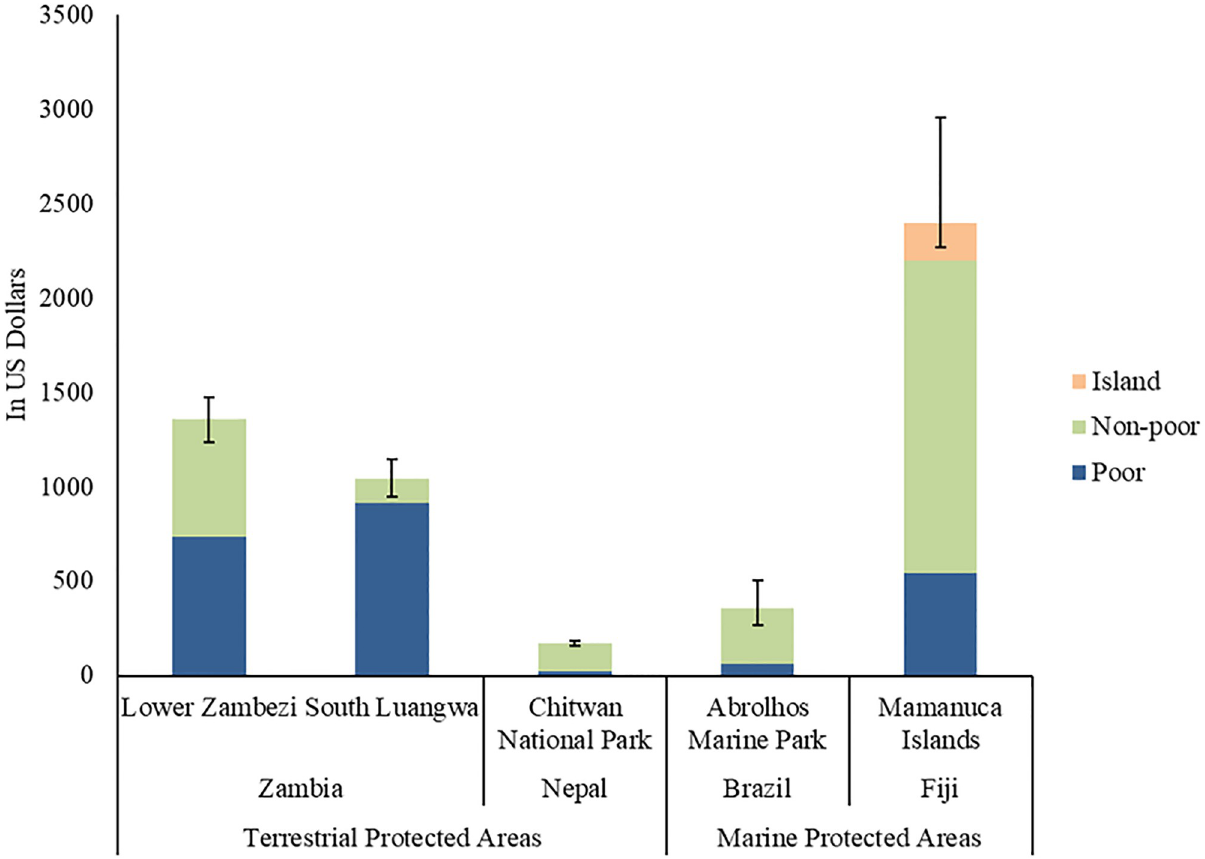
Fig 3. Impact of an additional tourist on real (inflation-adjusted) incomes in protected areas. The stacked vertical bars indicate the real (inflation- adjusted) impact of an additional tourist on total income in the local economy near the PA. The vertical line on each bar shows the confidence interval around this local economy impact. The blue and green colors decompose the total impacts by households’ poverty